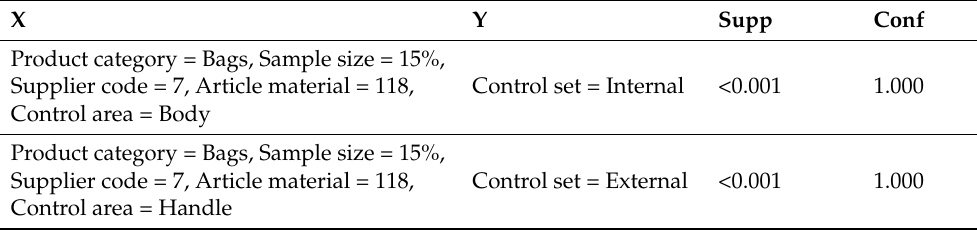
Table 5. Examples of the rules in the form of supplier code, sample size, product category, article material, control area, and control set.